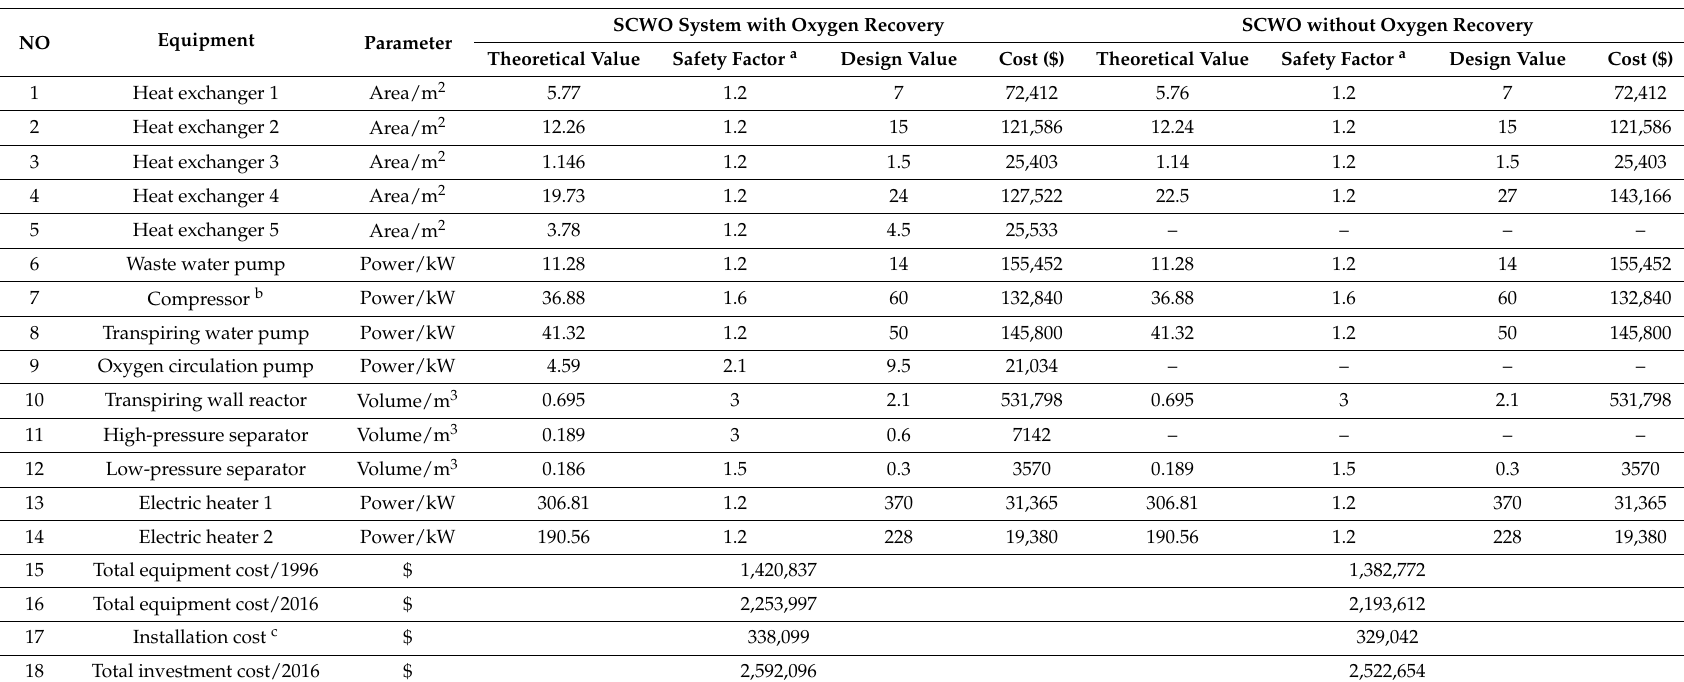
Table 6. Equipment